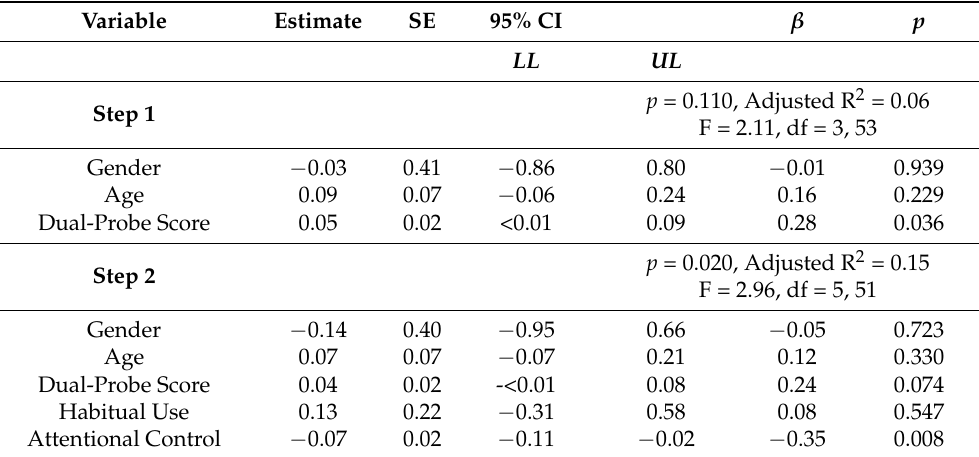
Table 3. Gender, age, dual-probe score, habitual use, and attentional control regressed on change in subjective craving. Variable